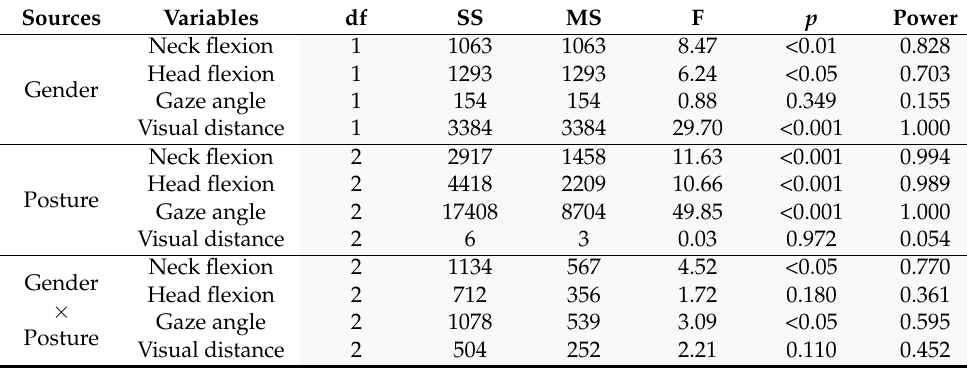
Table 3. Two-way ANOVA results.